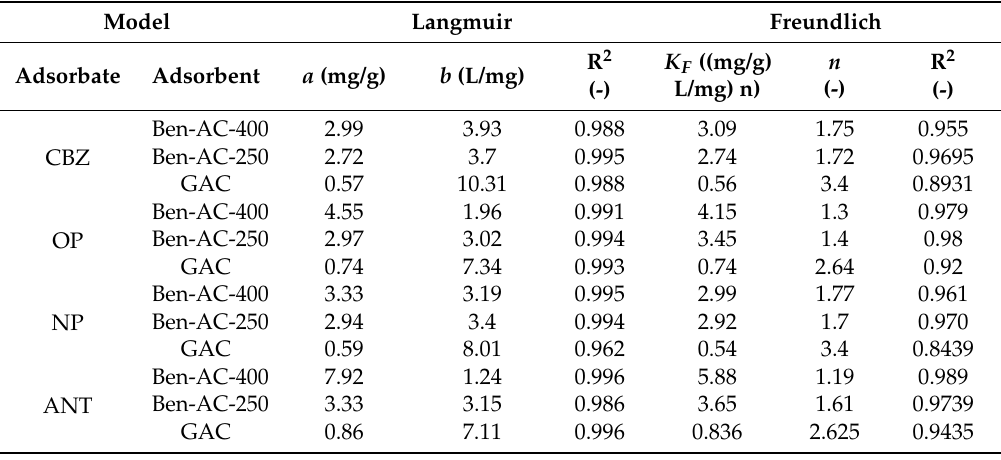
Table 5. Parameters of the Freundlich and Langmuir equations and correlation coefficients for the